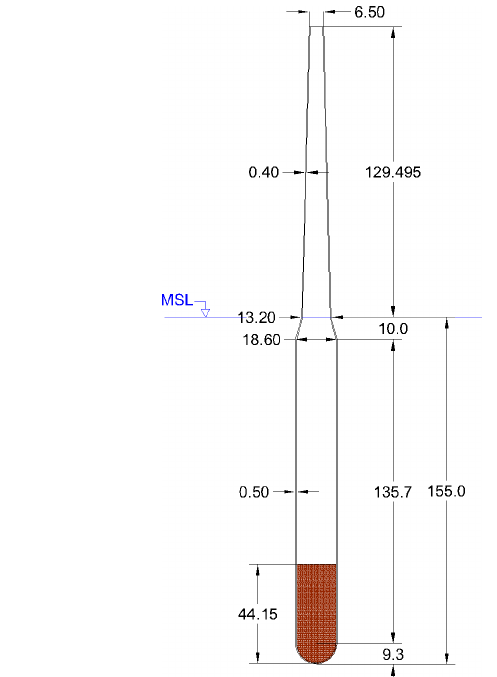
Figure 1. WindCrete geometry (units in m).